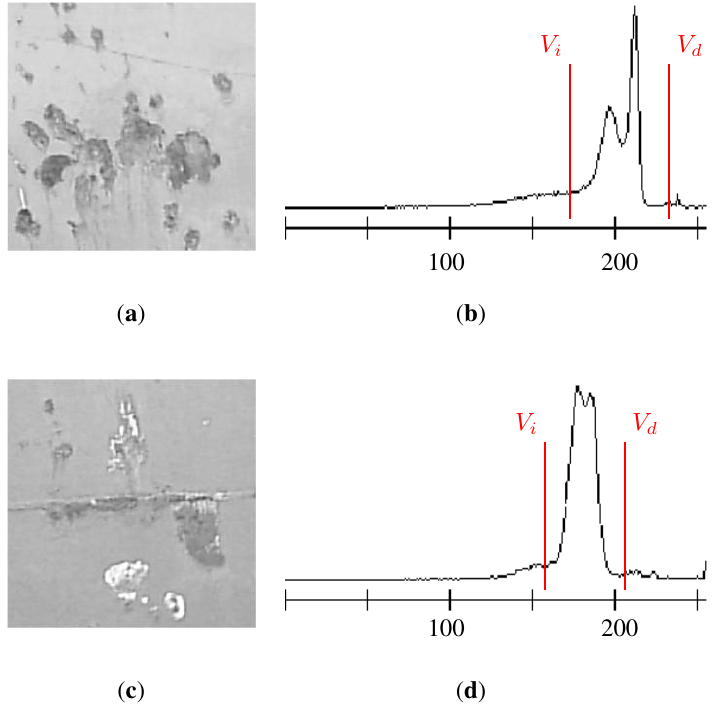
Figure 12. Images with defects and different illumination conditions ( a ), ( c ), and their corresponding histograms and determination of the HRBD ( b ), ( d ). ( a ) Image H1; ( b ) HRDB = 58 , S = 179 = 58 = 3 : 08 ; ( c ) Image H6; ( d ) HRDB = 48 , S = 168 = 48 = 3 : 04 . V i